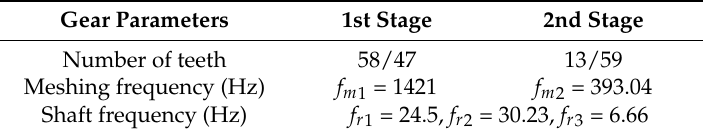
Table 1. Specification of two-stage helical gearbox. Table 1 . Specification of two ‐ stage helical gearbox.